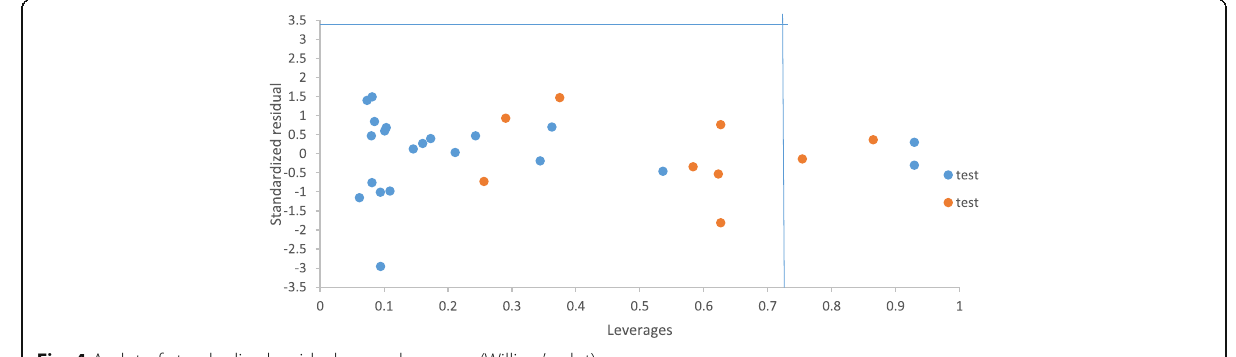
Fig. 4 A plot of standardized residual versus leverages (William ’ s